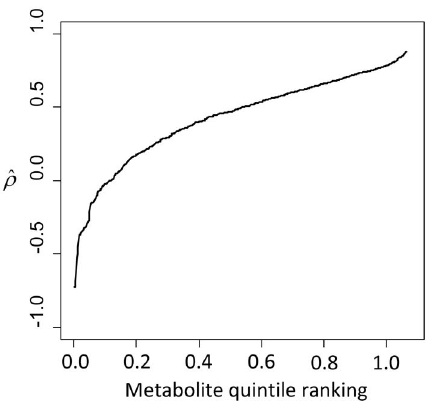
Figure 2. The plot illustrates the distribution of ^ rr , an estimate of a measure of autocorrelation over time, for all metabolites. The curve illustrates that the majority of r are likely above 0 and that measurements collected on consecutive days are likely more similar than those collected one week apart. The x-axis indicates the quantile ranking and y-axis indicates ^ rr for a metabolite at that ranking. For example, the median level, that of the metabolite ranked 284, is 0.49.